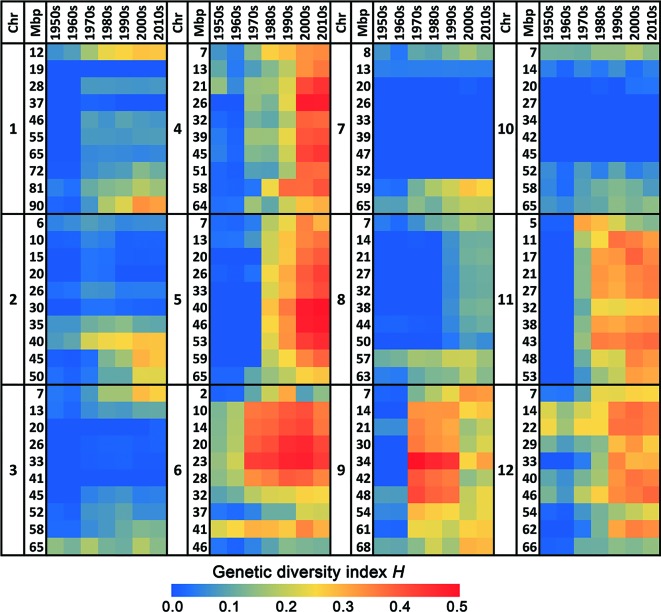
Heat map of the genetic diversity in the 12 chromosomes of commercial tomato varieties in course of time. The blue color indicates a very low genetic diversity in that decade for the respective chromosomal fragment, whereas a red color represents a very high genetic diversity.